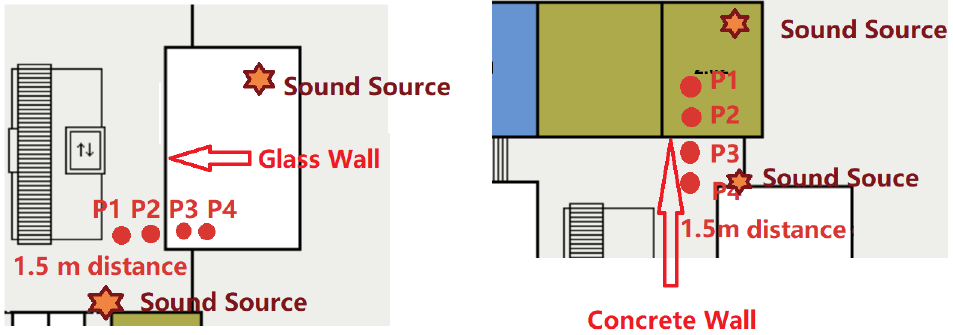
Figure 5. A preliminary sound and Bluetooth test with a concrete wall and glass wall between the smartphones(P1, P2, P3, and P4 were the four phones statically on tables of the same height. We brought two sound sources inside/outside the rooms to simulate environmental sound information. The sound was from a YouTube video playing mixed sounds from a supermarket. The phones were placed in line 1.5 m apart.